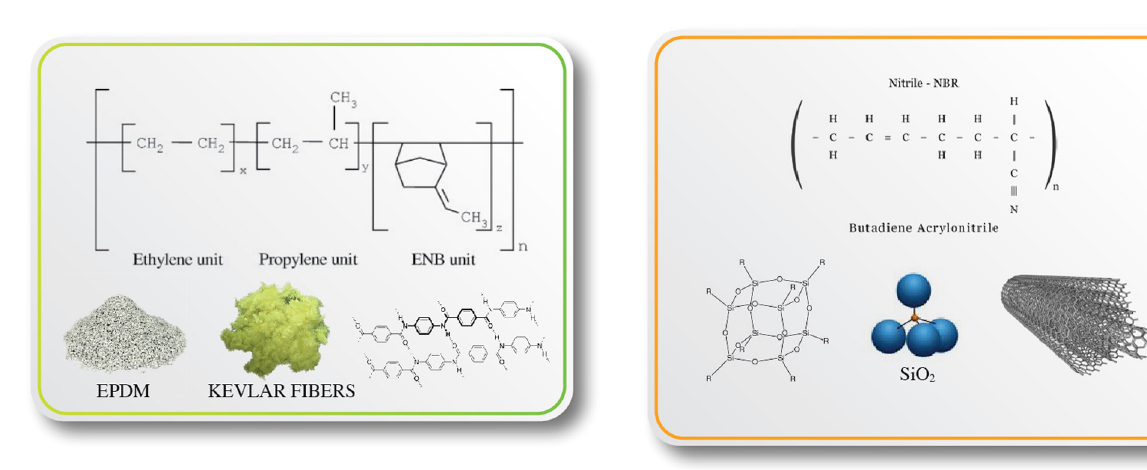
Figure 5: NBR EHSM and exemplary fi llers utilized